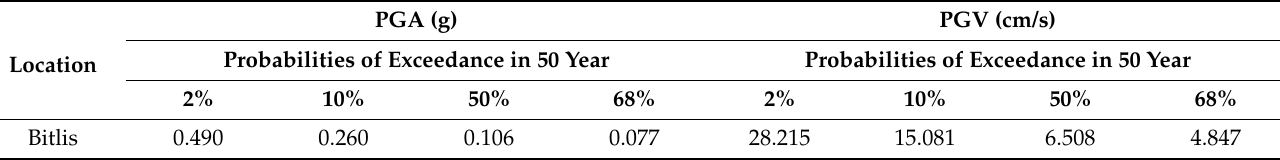
Table 4. Comparison of the PGA and PGV for different probabilities of exceedance.